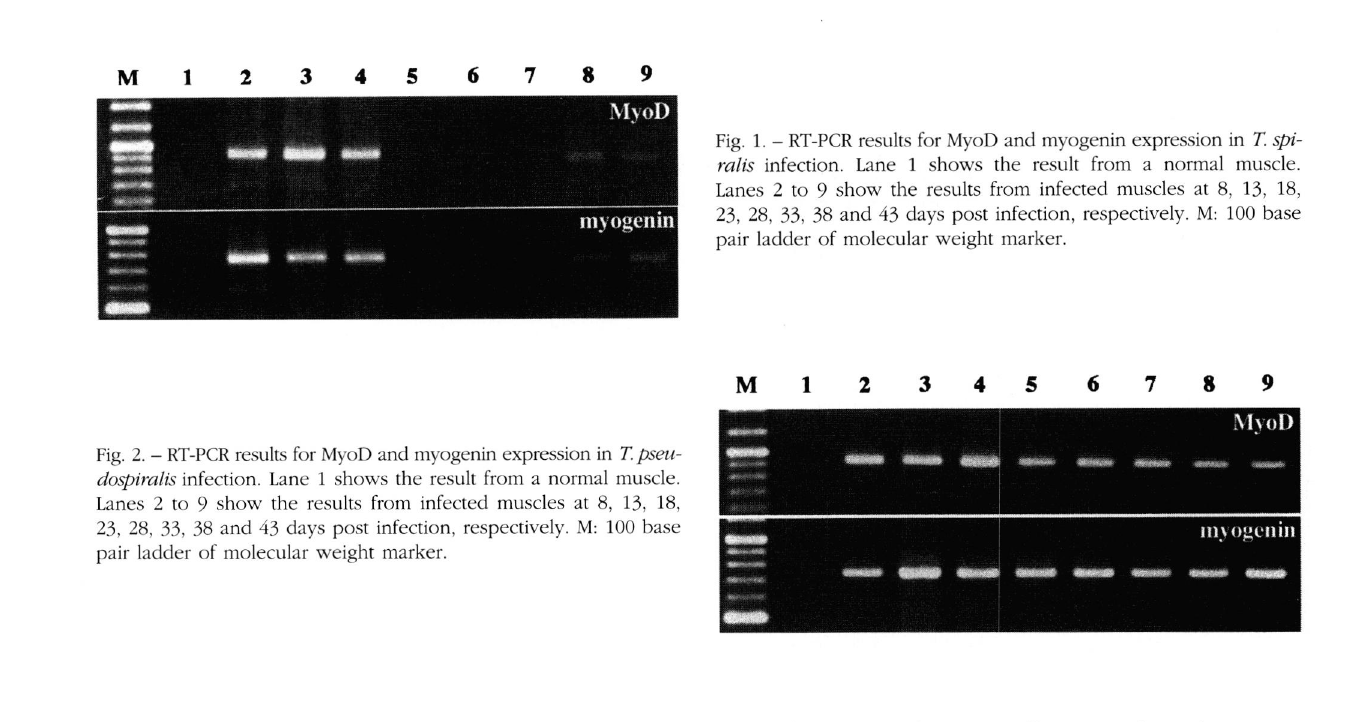
Fig. 2. - RT-PCR results for MyoD and myogenin expression in T. pseu- dospiralis infection. Lane 1 shows the result from a normal muscle. Lanes 2 to 9 show the results from infected muscles at 8, 13, 18, 23, 28, 33, 38 and 43 days post infection, respectively. M: 100 base pair ladder of molecular weight